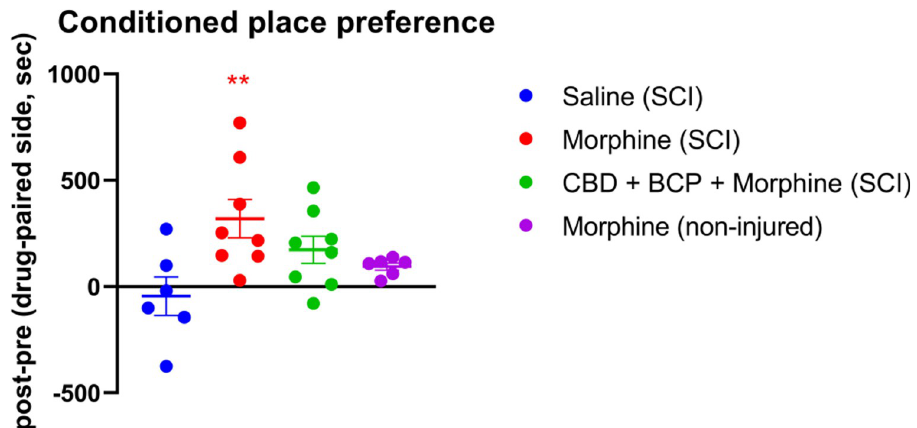
Fig 10. Conditioned place preference measurements. Data are shown as differences in time spent on the non- preferred side after conditioning minus pre-conditioning. Morphine (2 mg/ kg) was used as the conditioning analgesic agent in SCI or non-injured male rats; saline vehicle was used as conditioning control in SCI animals. Animals in the CBD/BCP group received CBD/BCP 1 hour prior to morphine during CPP training. �� denotes p < 0.01 compared to saline-paired SCI